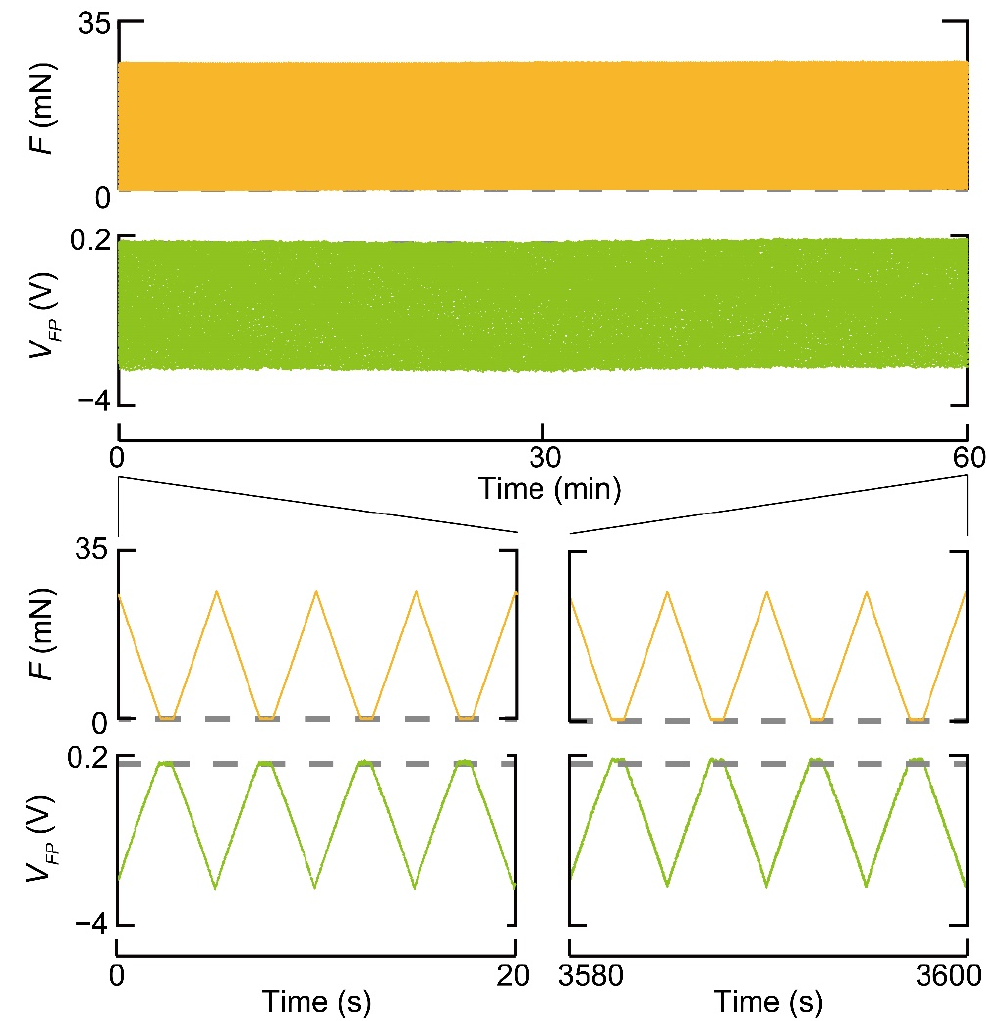
Figure 13. Measured F and V FP when the needle was pushed at the center for one hour.